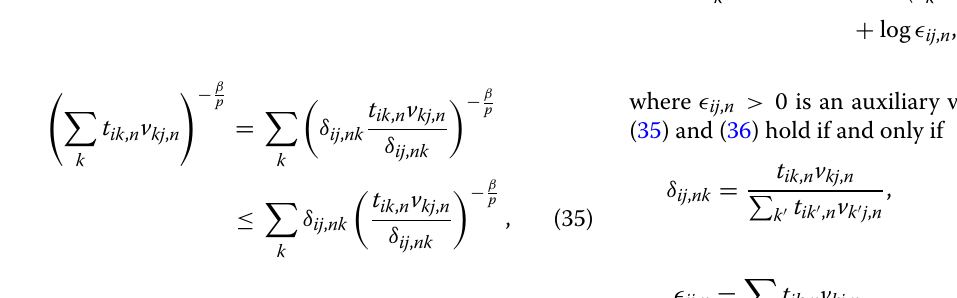
Fig. 11 Average SDR improvements of Music 2 signal with E2A_2 using fixed parameters. The results for GGD-IVA and t -MNMF using β = 0.5 and ν = 1 are shown, which are their best parameter settings β > 0 and p > 0, we can bound this term using Jensen’s inequality as